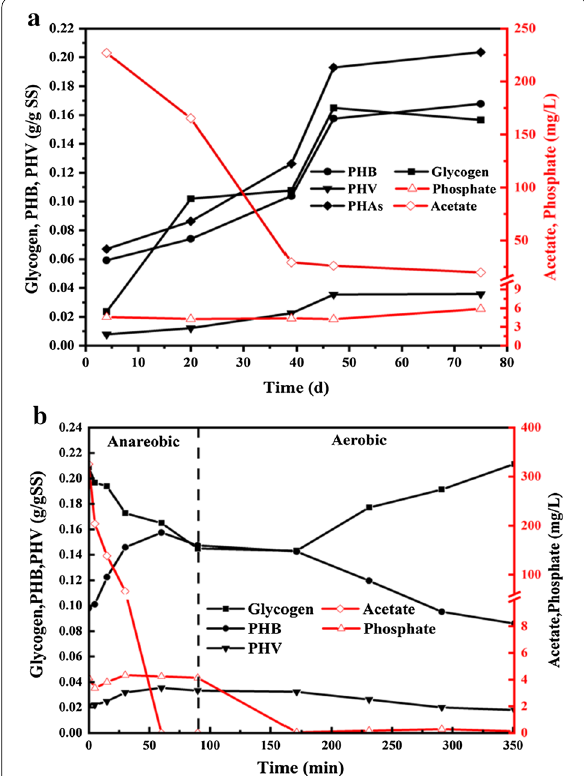
Fig. 2 The performance of the GAOs enrichment culture system. a The changing levels of Glycogen, Acetate, PHAs and Phosphorus transformation during the 75 days operation. b The change levels of Glycogen, Acetate, PHAs and Phosphorus transformation in a typical cycle of the steady